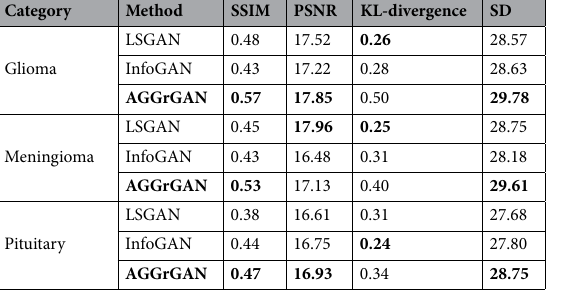
Table 3. Quantitative comparison of performance between existing GAN architectures like LSGAN, InfoGAN and the proposed AGGrGAN applied on the brain tumor dataset. Values in bold signify that they are—(i) the metric-wise best value obtained for the corresponding class for Tables 1, 2, 3, 4 and (ii) case-wise best performance obtained for a particular dataset.